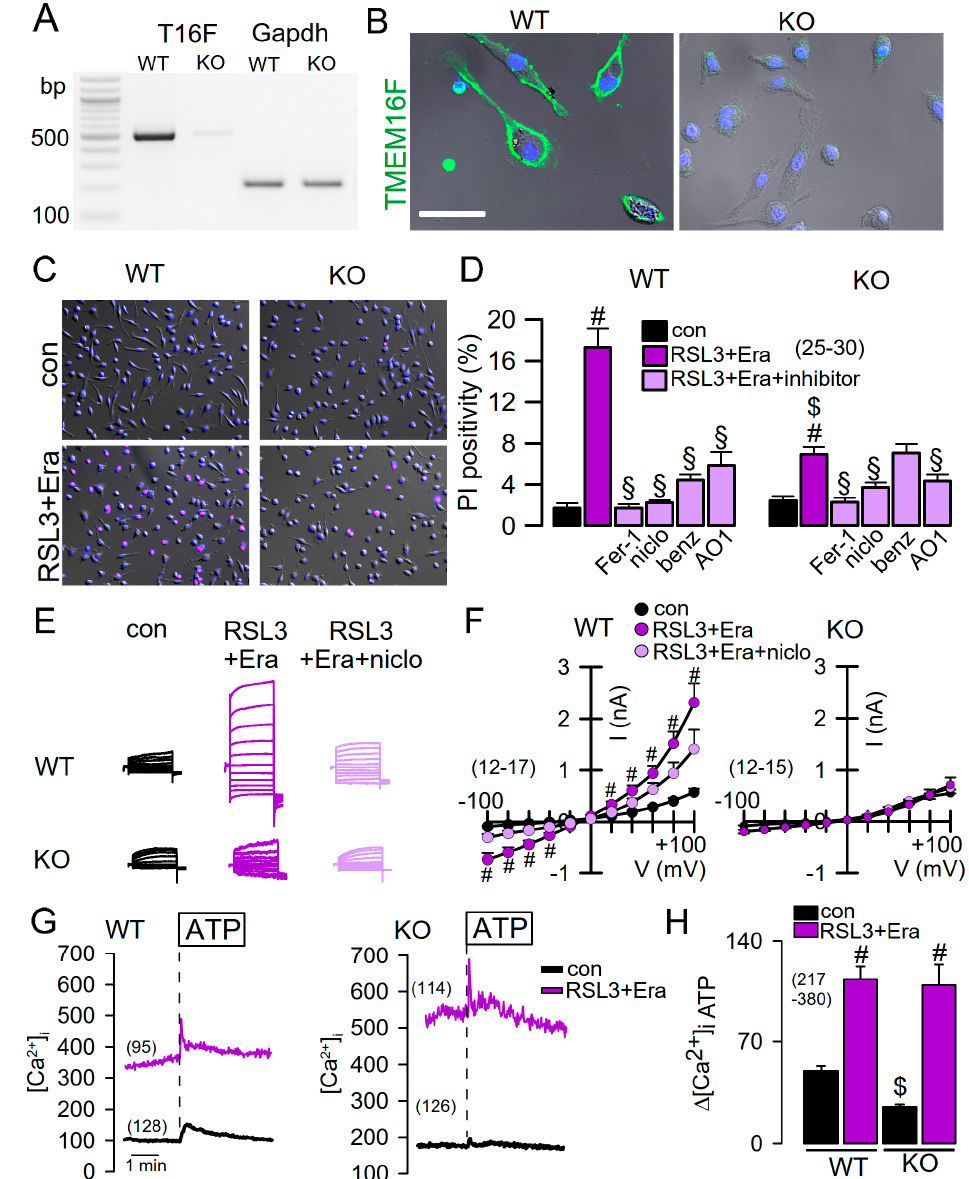
Figure 2. Reduced ferroptosis in macrophages from mice lacking expression of TMEM16F. ( A ) Semiquantitative RT-PCR indicating lack of expression of TMEM16F (T16F) in peritoneal macrophages isolated from mice with a tissue specific knockout of TMEM16F (TMEM16F flox / flox -Cx3cr1-Cre, KO; c.f. Methods). ( B ) Immunostaining of TMEM16F (green) in WT but not KO macrophages. Nuclei labeling by DAPI (blue). Bar = 20 µ m. ( C , D ) Propidium iodide (PI) staining of WT and KO macrophages and induction by RSL3 + erastin (1 / 5 µ M; RSL3-Era). Inhibition of PI positivity by ferrostatin-1 (Fer-1; 5 µ M) and by inhibitors of TMEM16F, niclosamide (niclo; 1 µ M), benzbromarone (benz; 5 µ M), and CaCCinhAO1 (AO1; 10 µ M), respectively. ( E ) Activation of whole cell currents by RSL3 + Era in WT but not KO macrophages, and inhibition of current activation by niclosamide (1 µ M). ( F ) Corresponding current / voltage relationships of currents measured in WT and KO macrophages. ( G , H ) Measurement of intracellular Ca 2 + concentrations before (con, black line) and after incubation with RSL3 and erastin (RSL3 + Era, purple), and activation of Ca 2 + store release by ATP (100 µ M). RSL3 + Era significantly increase basal intracellular Ca 2 + levels and augment ATP-induced Ca 2 + store release. Mean ± SEM (number of experiments). # significant di ff erence when compared with control ( p < 0.05, ANOVA). $ significant di ff erence when compared with WT ( p < 0.05, ANOVA). § significant inhibition by blockers ( p < 0.05,